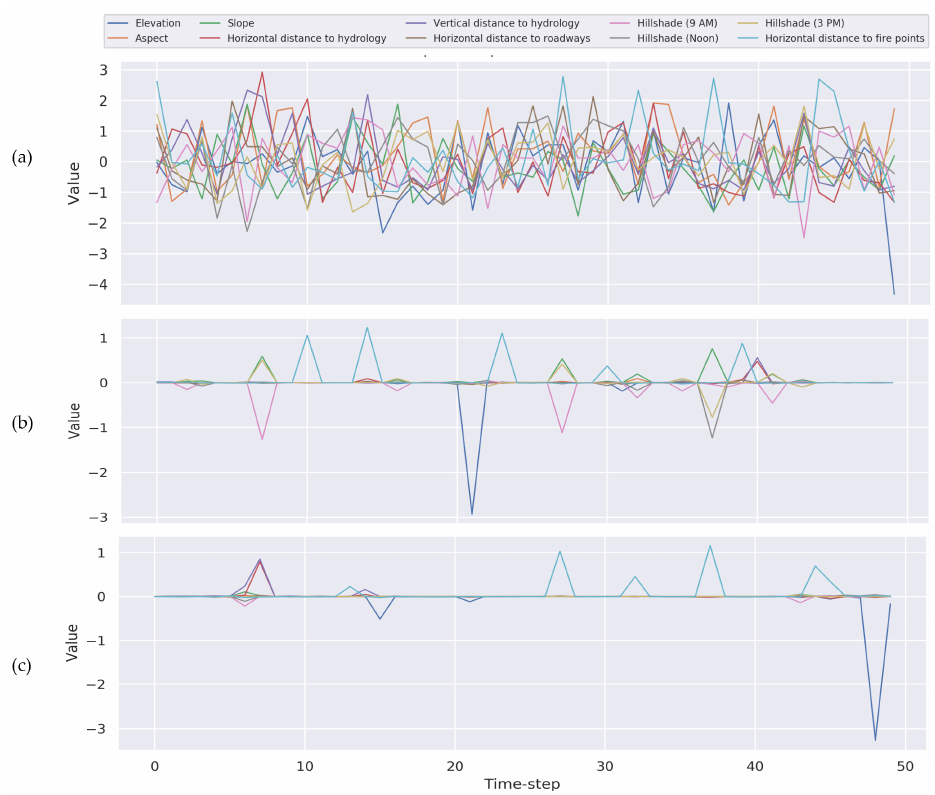
Figure 7. Auto-encoder training with different base models: ( a ) raw signal, ( b ) TSInsight attribution for the CNN and (c) TSInsight attribution for LSTM.